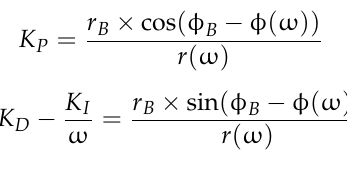
Figure 3. Stabilizing region and ϕ m = 60 ◦ boundary curve in the K P - K I parameter plane for the